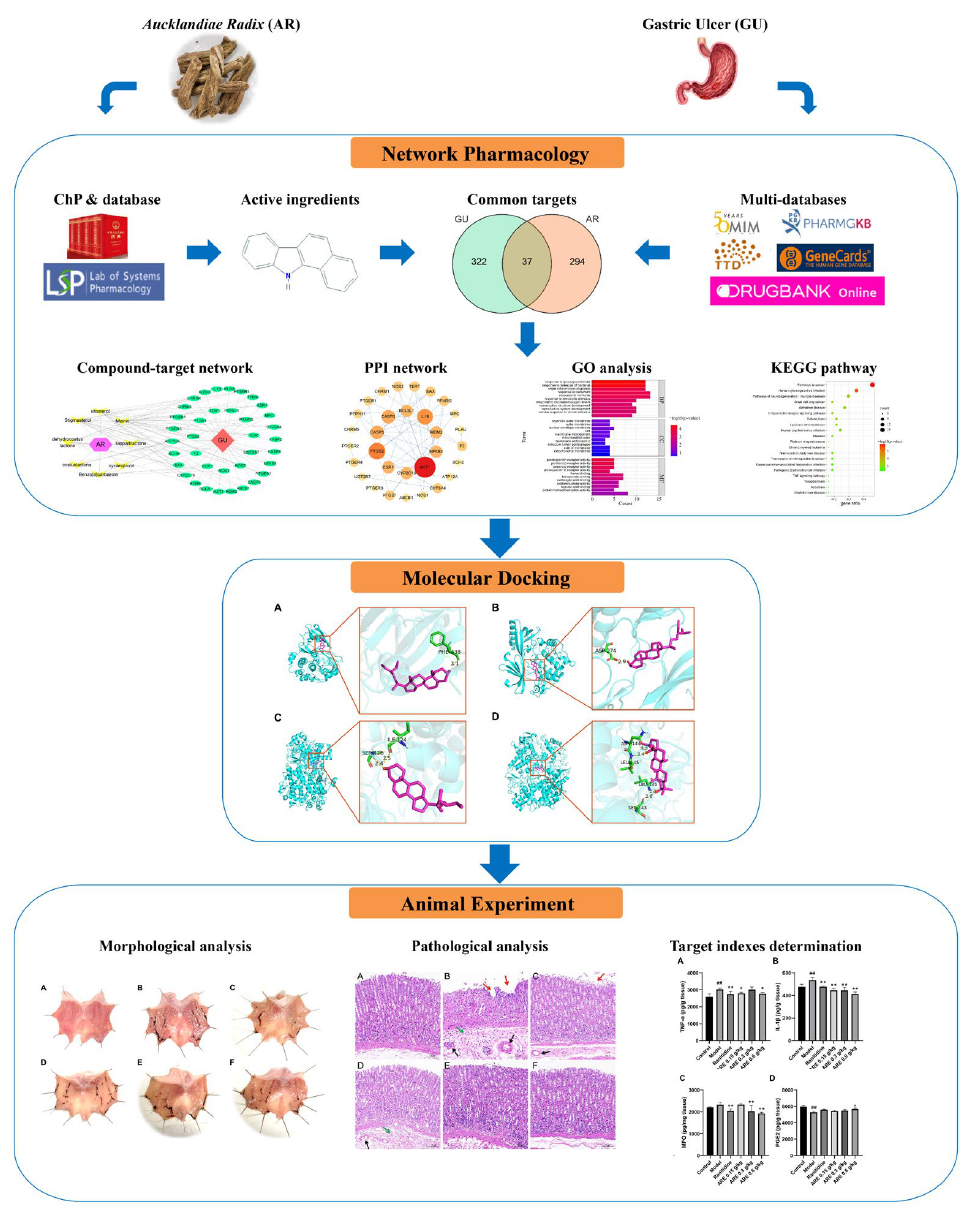
Figure 1. Workflow of this study. In the molecular docking section, ( A ) The docking result of AKT1 with stigmasterol, ( B ) The docking result of AKT1 with sitosterol, ( C ) The docking result of PTGS2 with stigmasterol, ( D ) The docking result of PTGS2 with mairin; In morphological and pathological section, ( A ) Control group, ( B ) Model group, ( C ) Ranitidine group, ( D ) ARE 0.15 g/kg group, ( E ) ARE 0.3 g/kg group, ( F ) ARE 0.6 g/kg group; the red arrow, epithelial cell loss; the green arrow, inflammatory exudation and infiltration; and the black arrow, vasocongestion; In target indexes determination section, ( A ) TNF- α , ( B ) IL-1 β , ( C ) MPO, ( D ) PGE2; ## p < 0.01 when compared with the control group; * p < 0.05, ** p < 0.01 when compared with the model